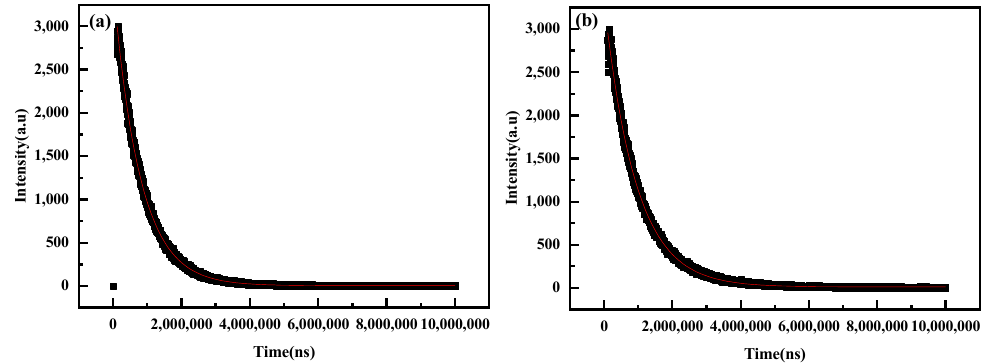
Figure 7. The fluorescence decay curves of the europium complex powders ( a ) and polyurethane– europium material containing 3 wt% europium complex ( b ) at 617 nm ( λ ex = 394 nm) at room temperature.